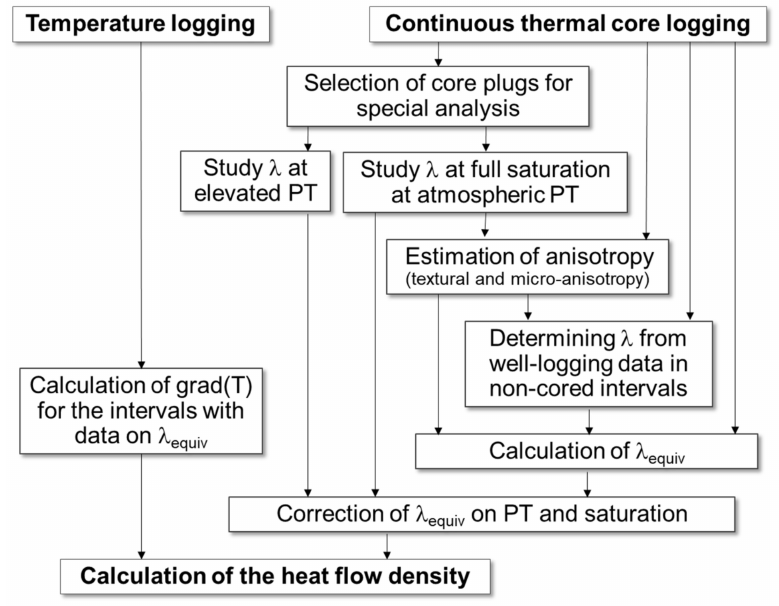
Figure 3. Workflow for determining heat flow